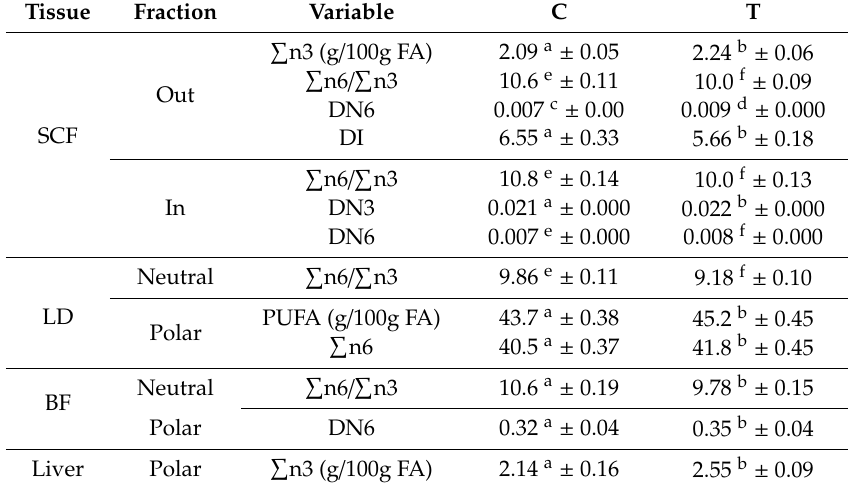
Table 4. Highlight of significant di ff erences ( p < 0.05) ± S.E.M. in fatty acid composition, at 60 days-old, between pigs born from sows treated or not with hydroxytyrosol and linseed oil during pregnancy (groups T, n = 17, and C, n = 18, respectively). Complete data are o ff ered in Supplementary Tables